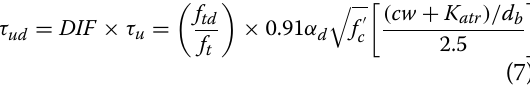
concrete; and K atr coefficient related to confinement of = transverse bars (Table 6). Figure 12 compares the test results with the bar stress predictions considering the strain rate effect on concrete tensile strength and neglecting concrete cover. Because